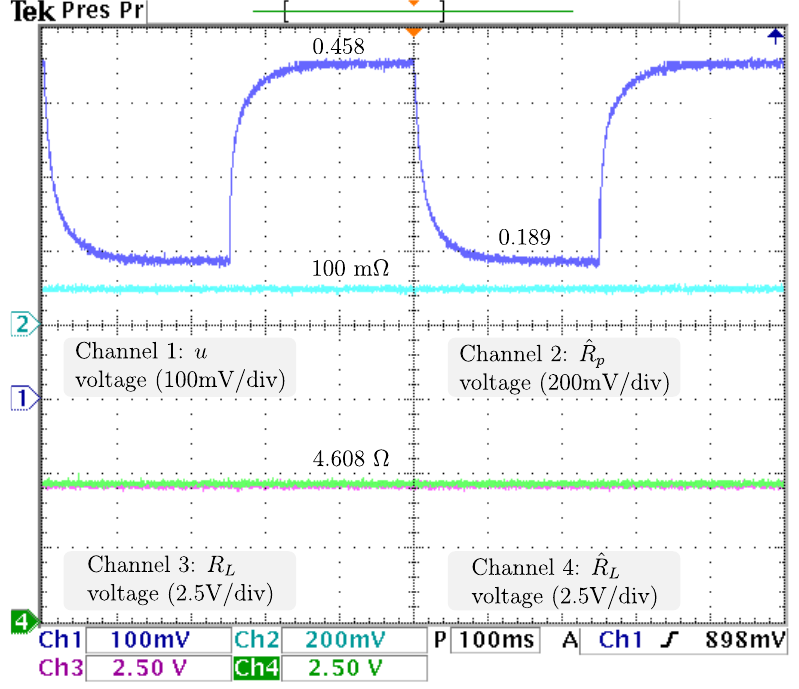
Figure 10. Real-time results for sudden output voltage changes. From top to bottom: u , the control signal; ˆ R p , the estimation of the parasite resistance; R L , the load; and ˆ R L = 1/ ˆ θ L , the estimation of the load through its